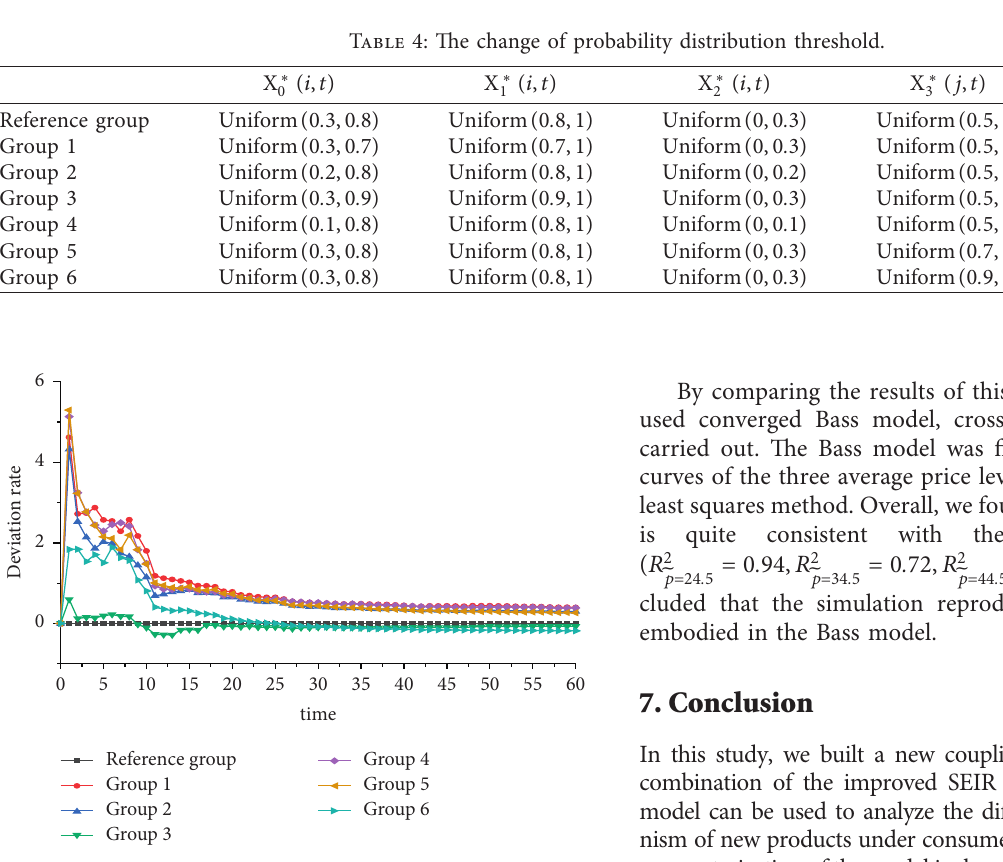
Figure 14: Sensitivity analysis of probability distribution